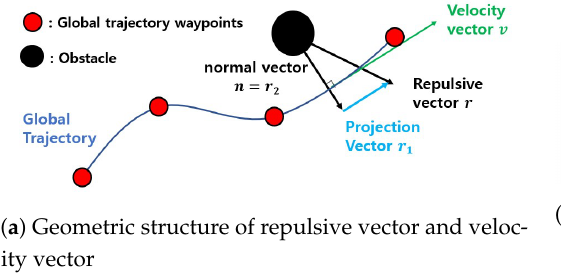
Figure 1. Local trajectory